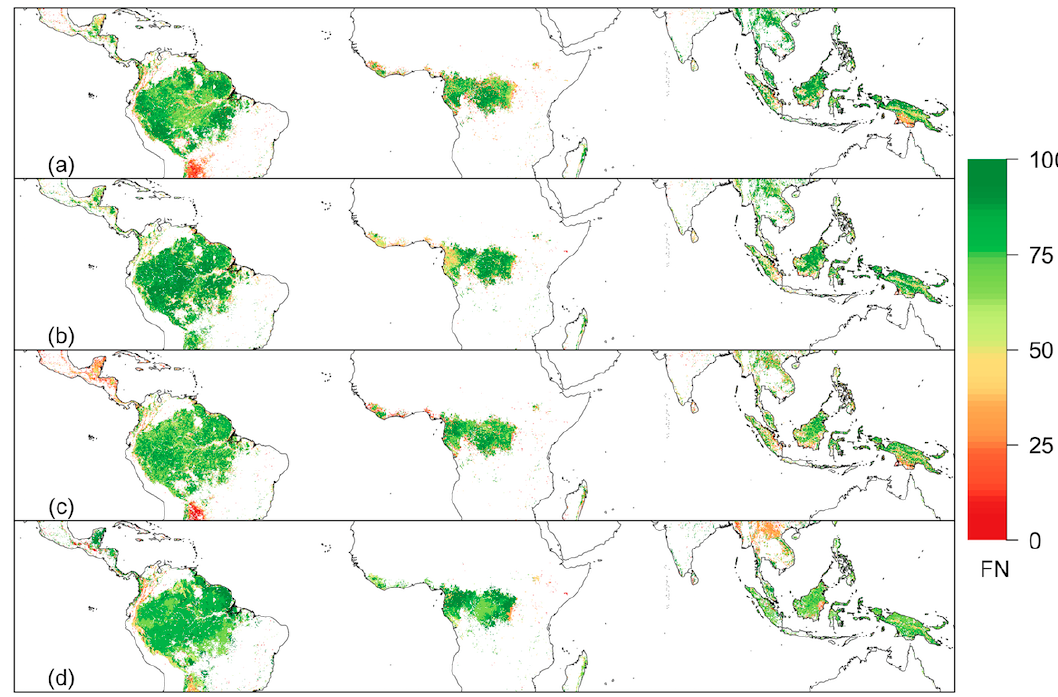
Figure 8. The spatial similarity map between our global wall-to-wall forest AGB product and the products from ( a ) Saatchi et al. (2011) [48]; ( b ) Baccini et al. (2012) [49]; ( c ) Avitabile et al. (2015) [72]; and ( d ) Reusch & Gibbs (2008) [73] in pan-tropical forest areas.